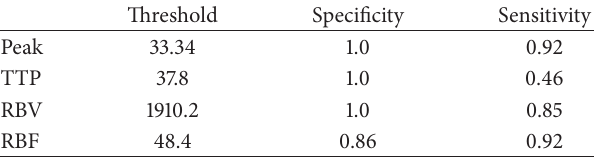
Table 4: Best cut-off values as determined by the Youden